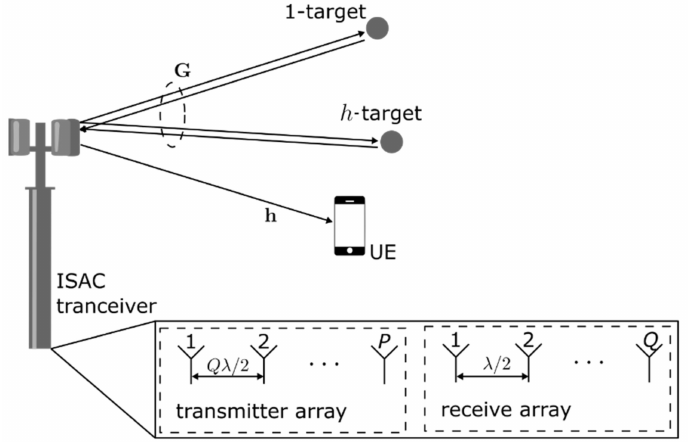
Figure 1. MIMO-OFDM monostatic ISAC